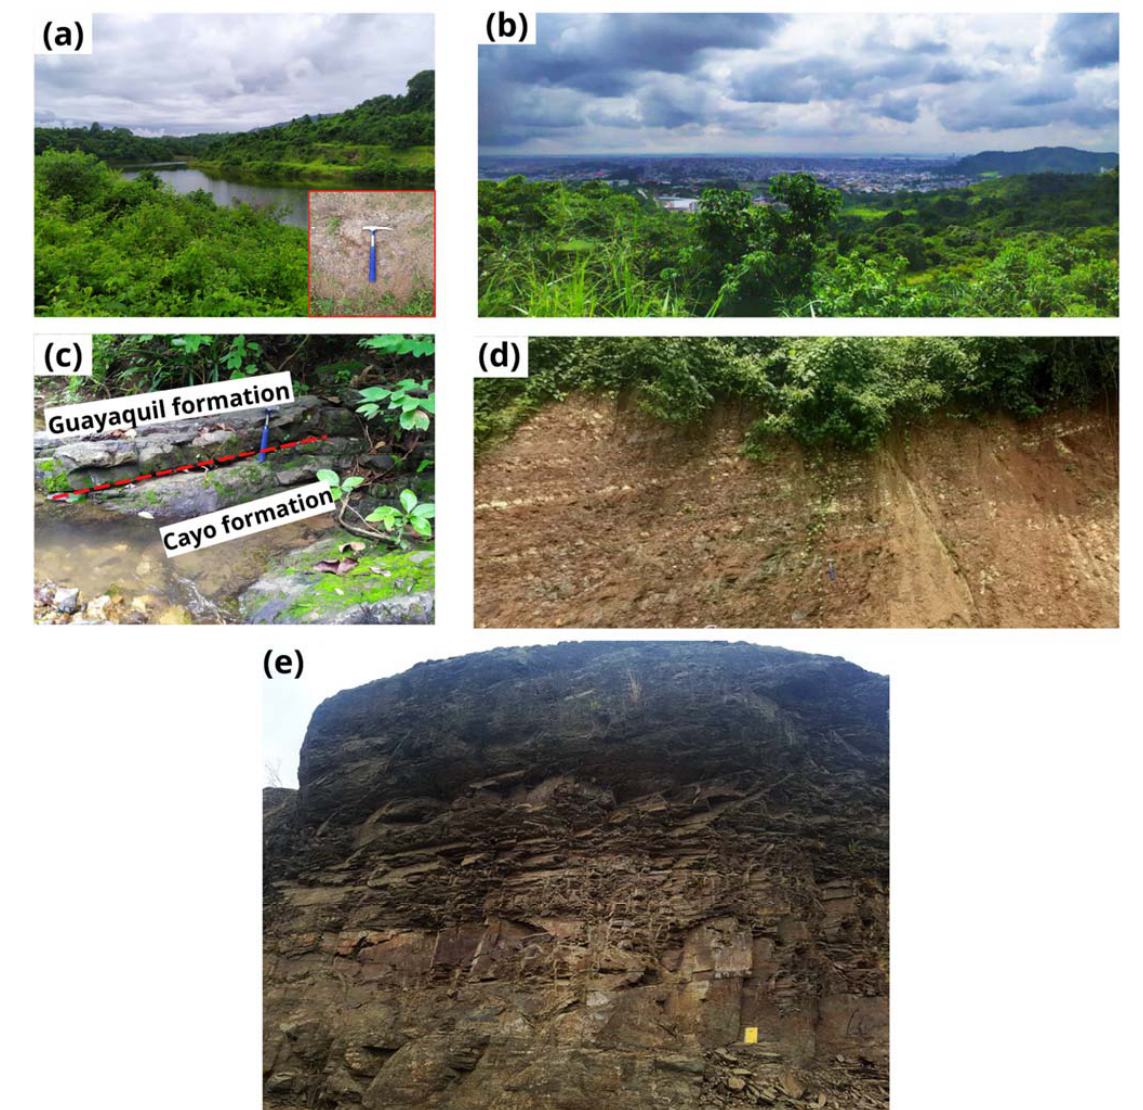
Figure 4. Sites of geological interest within the university campus: ( a ) lapilli tuff (SGI 1); ( b ) “La Prosperina” protective forest (SGI 2); ( c ) Cretaceous–Paleogene (K–Pg) boundary (SGI 3); ( d ) zeolite outcrop (SGI 4); and ( e ) volcano-sedimentary rhythmic sequence (SGI 5).